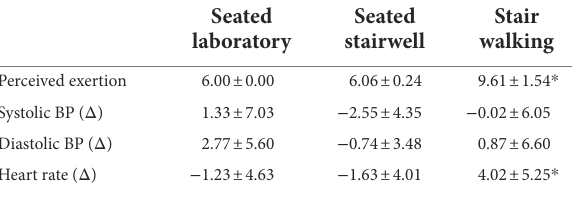
TABLE 3 Outcomes (M ± SD) related to exercise intensity by